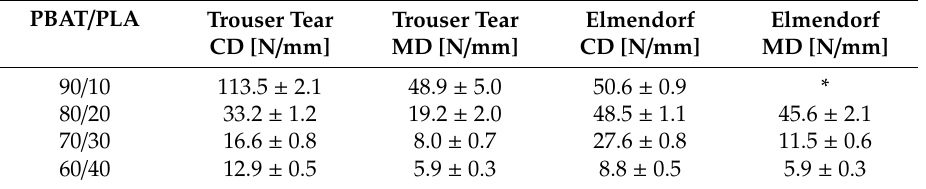
Table 6. Tear Propagation Resistance of Blown Films in Cross and Machine